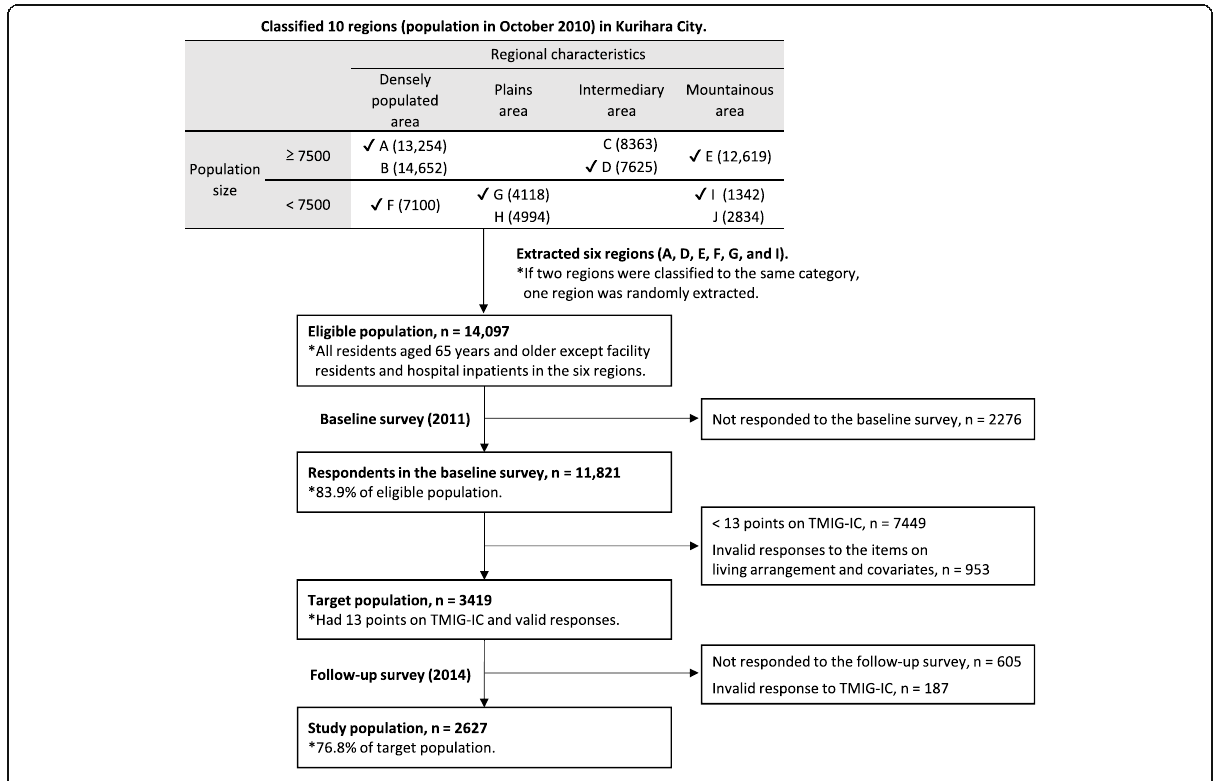
Fig. 1 Conceptual framework for sampling the study